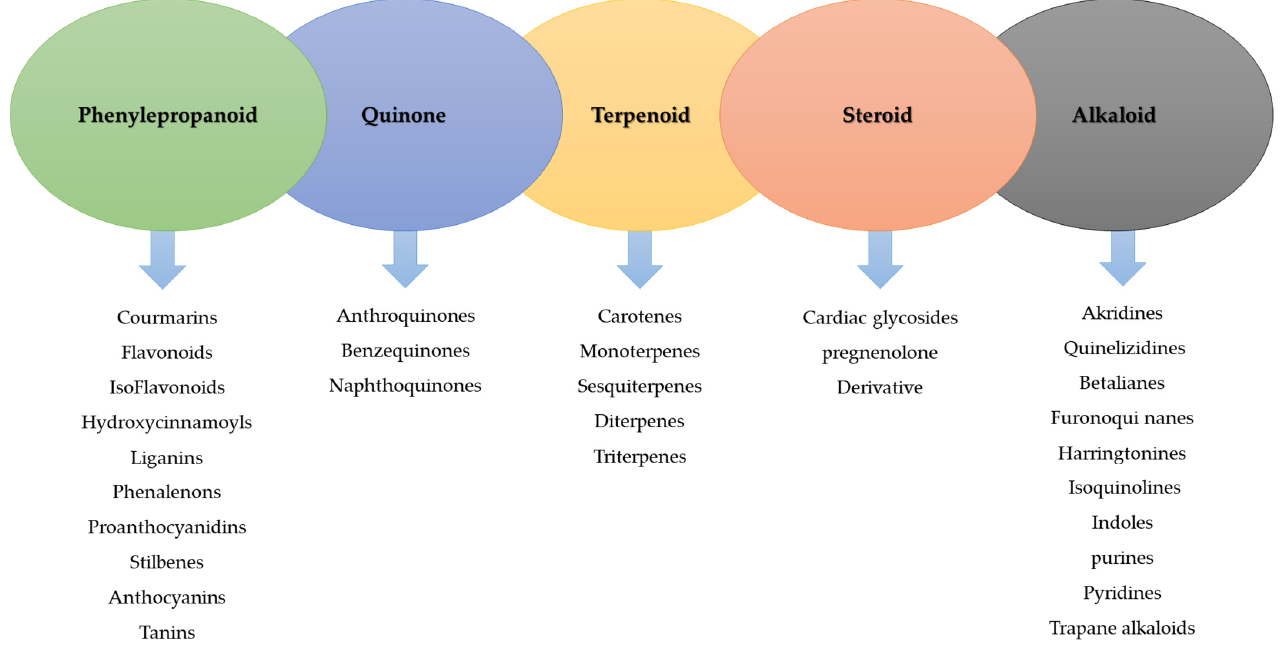
Figure 1. Classification of the active ingredients of medicinal plants (modified from Sidhu [10]).